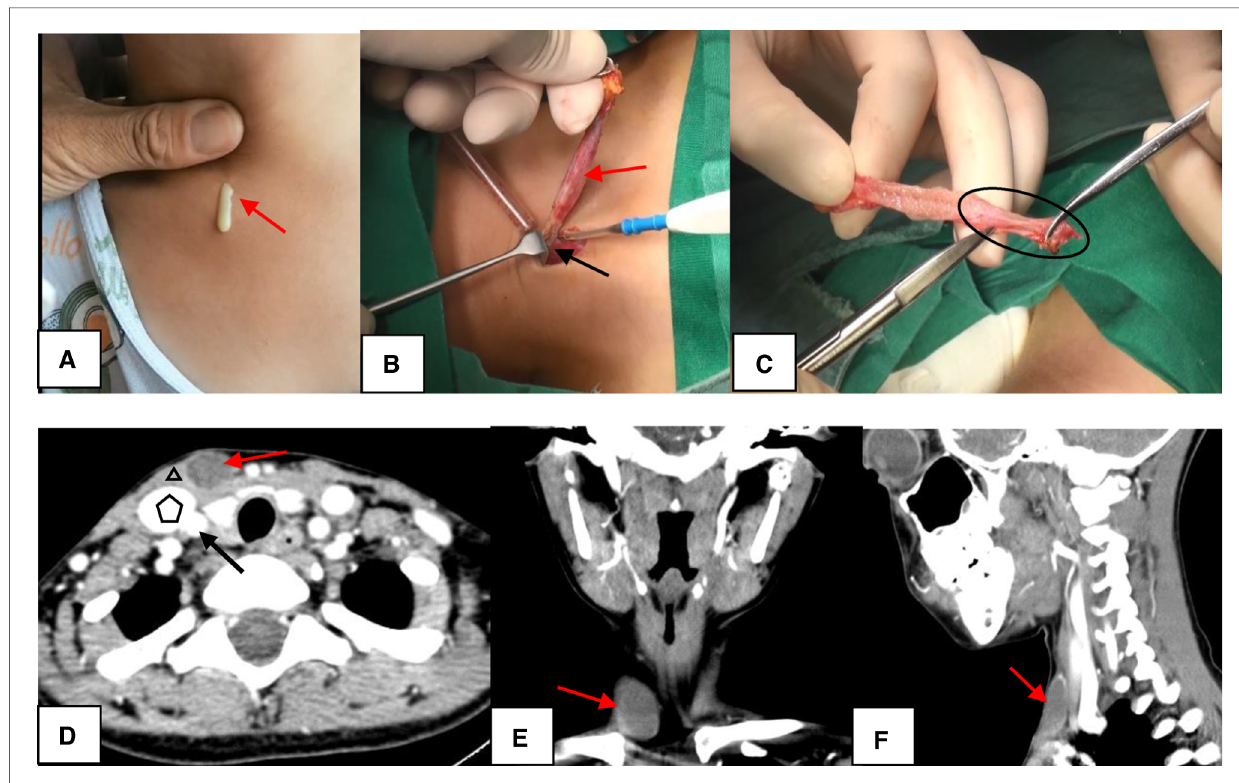
FIGURE 1 The Bailey type I. ( A ) The sinus was presented as having a skin pit on the lateral neck and discharge from the skin opening (red arrow). ( B ) The sinus (red arrow) terminated at the surface of SCM (black arrow). ( C ) The end of the sinus closed to form a muscle bundle (circle) ending at the surface of SCM. ( D – F ) On CT, the lesion (red arrow) lied along anterior surface of SCM (triangle) just deep to platysma, not in contact with the carotid sheath (pentagon: internal jugular vein; black arrow: arteria carotis communis). D, axial position; E, coronal position; F, sagittal position; SCM, sternocleidomastoid muscle; CT, computed